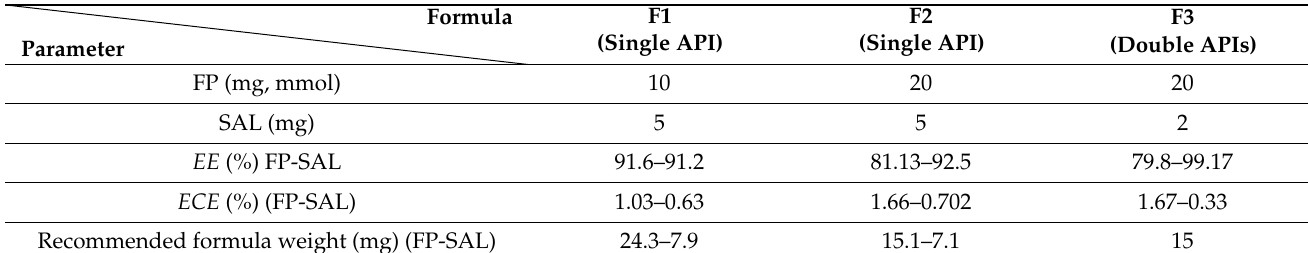
Table 3. API of (FP-SAL/Lys-PA) NCs with composition, EE %, ECE %, recommended formula weight, EE % and FPP%.